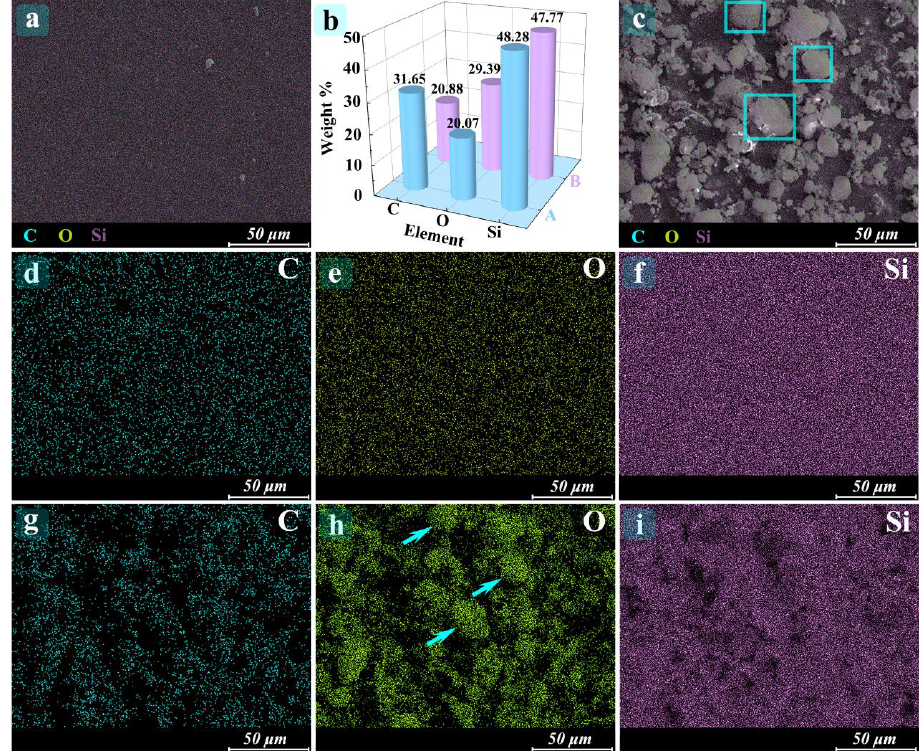
Figure 5. ( a ) Shows the surface element distribution of sample A; ( b ) is the bar chart of surface element content of samples A and B; ( c ) is the surface element distribution of sample B; ( d – f ) are respectively energy spectra of elements C, O, Si in the scanning region of energy spectrum of sample A; ( g – i ) are, respectively, energy spectra of elements C, O, Si in the scanning region of energy spectrum of sample B.